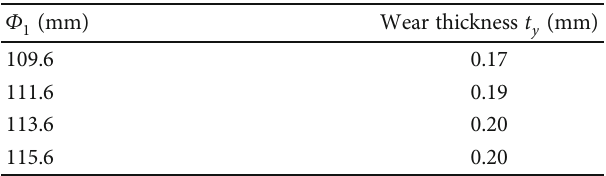
Figure 26: Unlocking force corresponding to di ff erent Φ = 0 : 05 , θ = 45 ° , and Φ